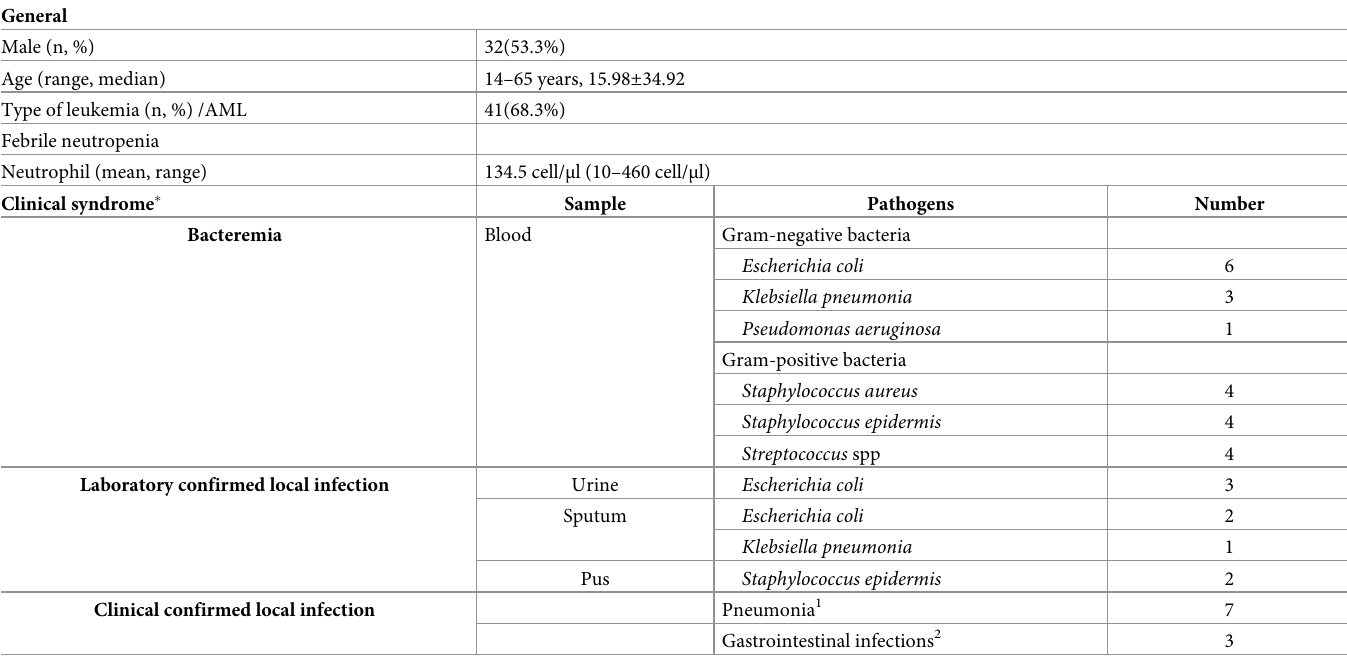
Table 1. Characteristics of the study patients and sites of infection.